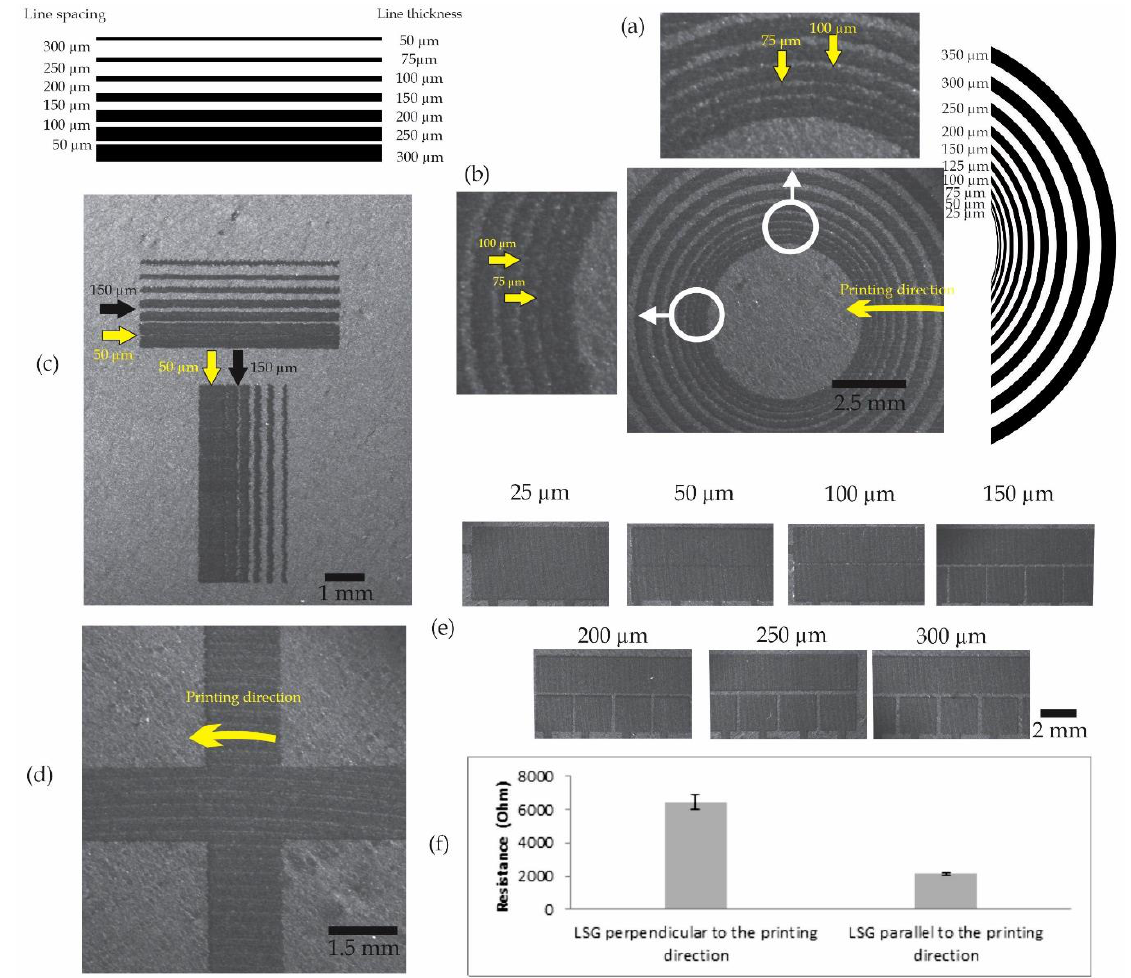
Figure 4. Printing concentric circles with resolutions increasing from 25 to 350 µm to assess and characterize the printing quality in all the directions and angles in ( a , b ). ( c ) Printing resolution test on vertical and horizontal lines. ( d ) Two long electrodes printed in the vertical and horizontal directions, 15 × 1.6 mm, to investigate the effect of the printing direction on the measured resistance in ( f ). ( e ) DMF electrodes printed at different resolutions. ( f ) The resistance of the two laser-scribed graphene electrodes in the horizontal direction (parallel to the printing direction) and the vertical direction (perpendicular to the printing direction).